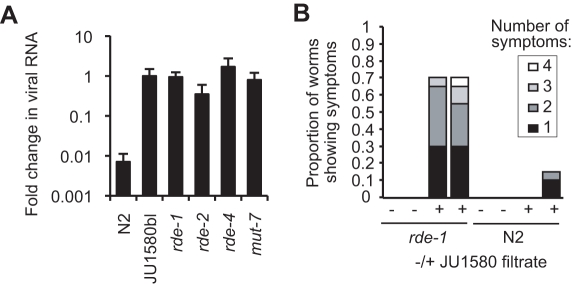
RNAi-deficient mutants of C. elegans can be infected by the Orsay virus.(A) JU1580bl, N2, rde-1(ne219) (n = 10 independent replicates each), rde-2(ne221), rde-4(ne301), and mut-7(pk204) (n = 5 independent replicates each) were tested by qRT-PCR for infection with Orsay virus extract. RNA levels were normalized to ama-1 and shown as average fold-change relative to JU1580bl. Error bars represent SEM. Same results as displayed in Figure 5C for N2 and JU1580. (B) Scoring of symptoms in two independent replicates of infection of rde-1 mutant and wild-type N2 animals by the Orsay virus filtrate, after 4 d.